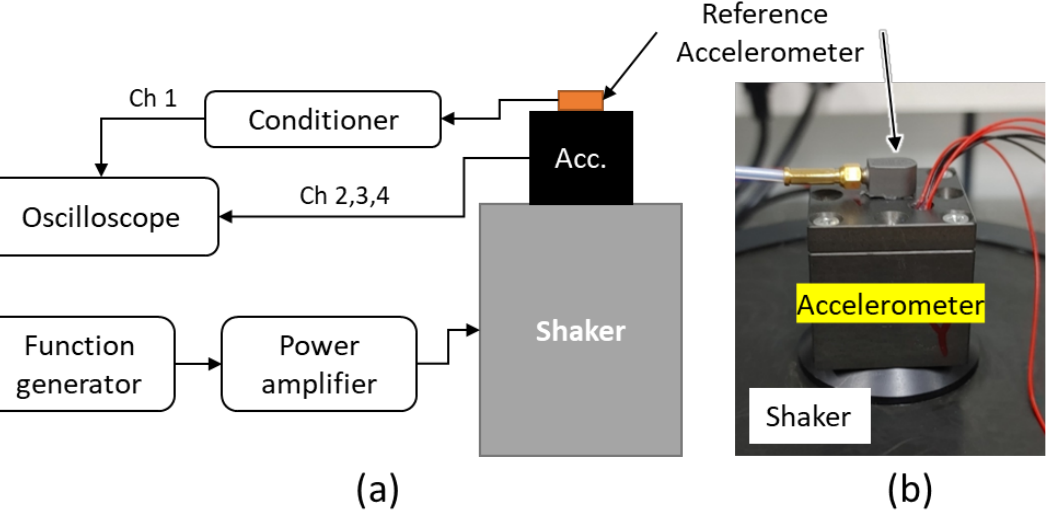
Figure 6. ( a ) Schematic illustration and ( b ) photograph of the sensitivity measurement setup.